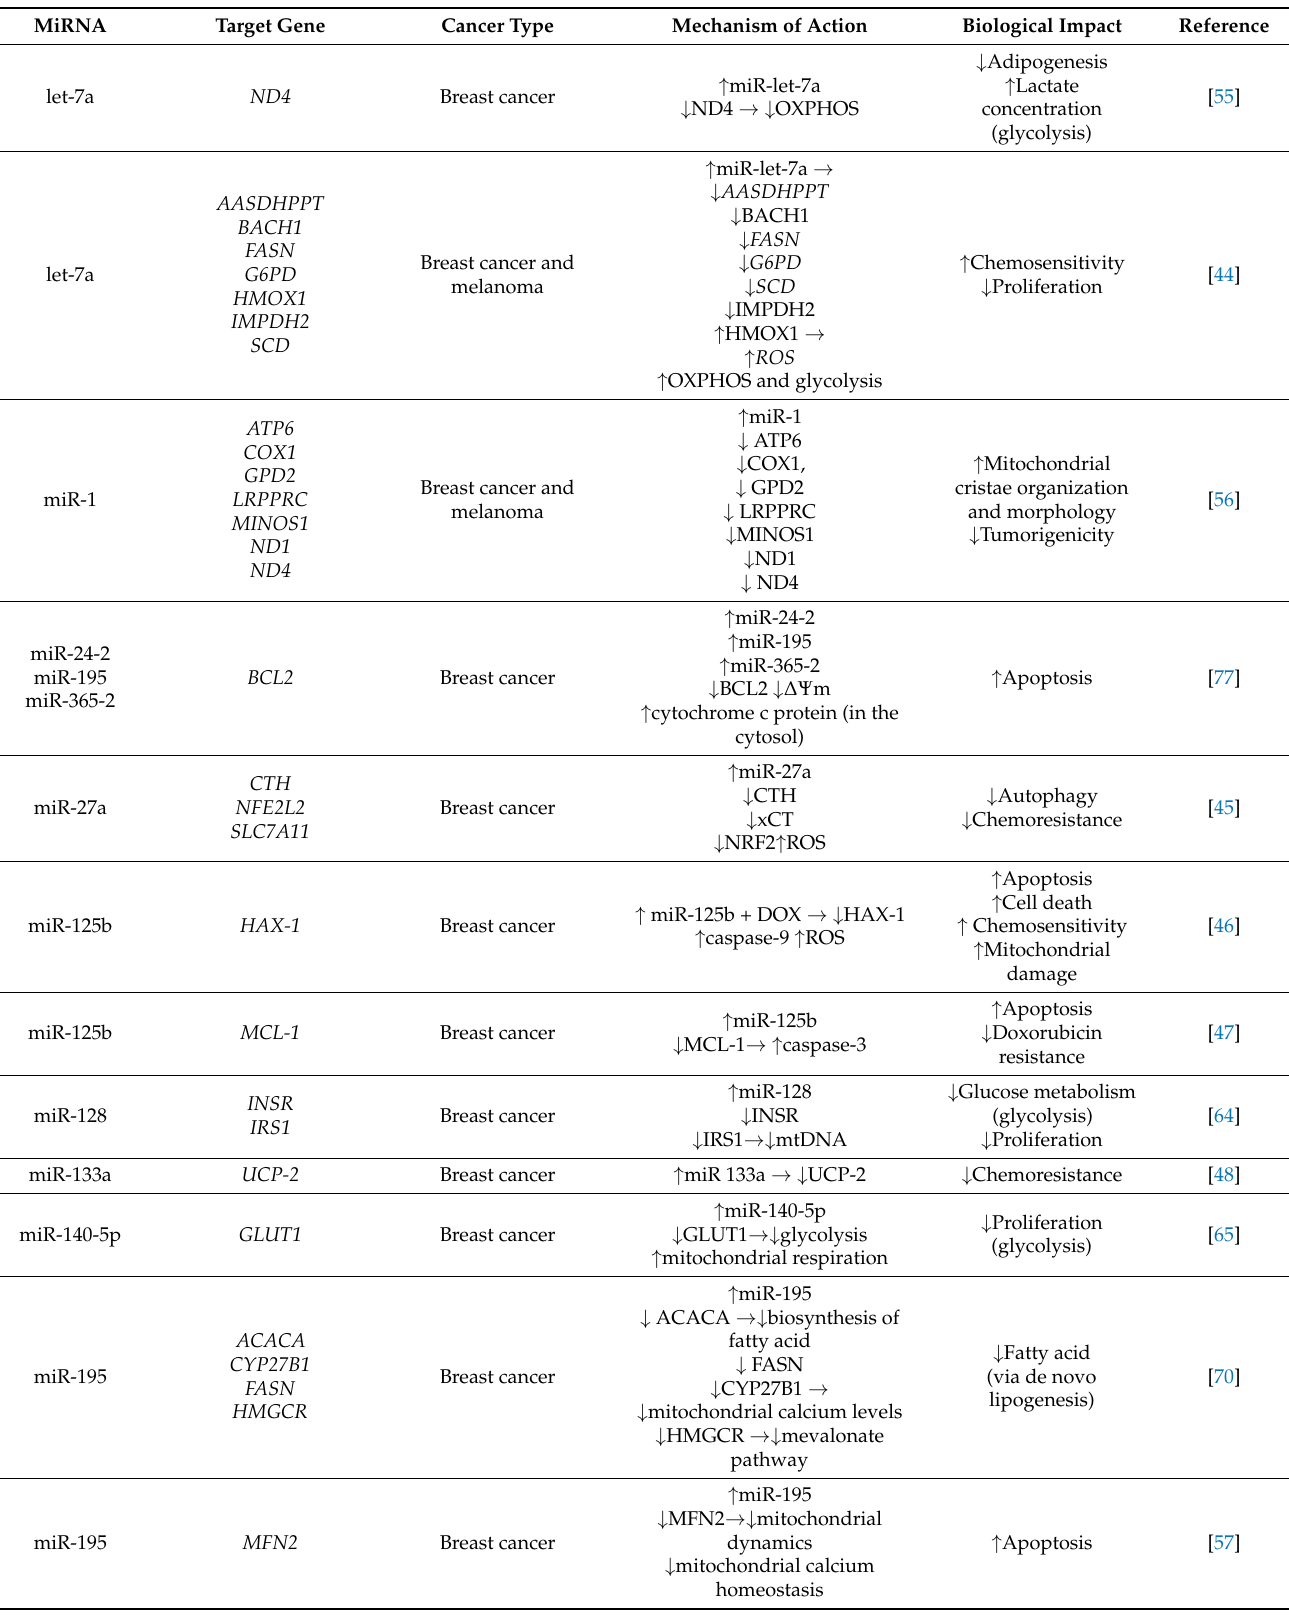
Table 2. MiRNAs identified with tumor suppressor function, their target genes, mechanisms of action, and corresponding impacts on distinct cancer cells phenotypes (presented by type of